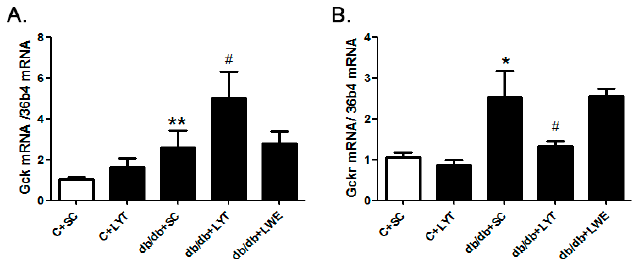
Figure 8. The mRNA expression of Gck ( A ) and Gckr ( B ) in the liver of the control and db/db mice at 20 weeks old. Values are means ± SE ( n = 4–6). * p < 0.05; ** p < 0.01 when compared with the C + SC group; # p < 0.05 when compared with the db/db + SC